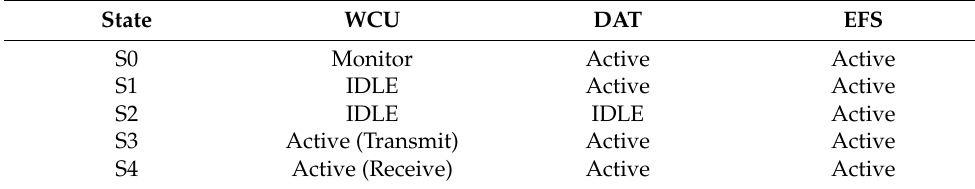
Figure 3. State transition diagram of Xbee-Pro module. Table 4. States of wireless sensor node.